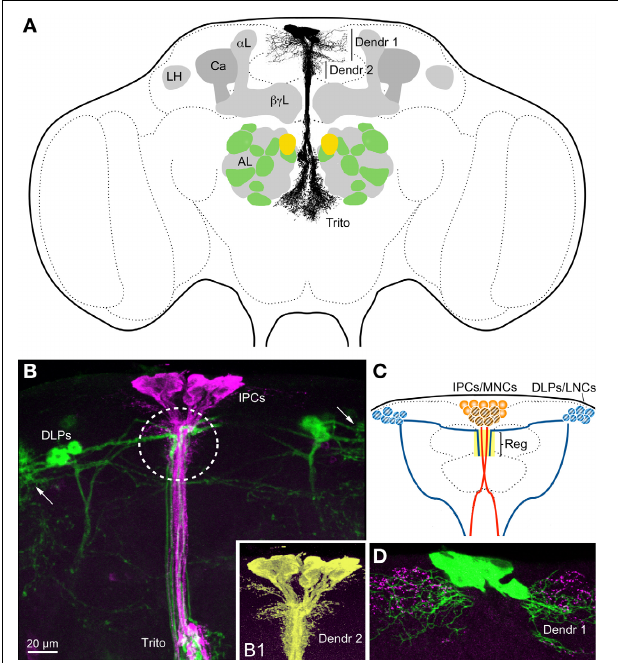
FIGURE 2 | Insulin-producing cells (IPCs) and other neurons in the Drosophila brain. (A) The IPCs are seen with their cell bodies dorsally, two sets of presumed dendrites (Dendr 1 and 2) in the pars intercerebralis and processes branching in the (tritocerebrum Trito). It is not known whether these branches are dendrites or axon terminations, or both. The axons that exit to the corpora cardiaca and aorta are not displayed (they exit above the tritocerebrum, in a direction toward the reader). The antennal lobes (AL) are depicted with the anterior 10 (green and yellow) of the about 14 glomeruli that contain olfactory sensory neurons (OSNs) expressing short neuropeptide F (sNPF). The yellow glomeruli are DM1 that receive OSNs expressing odorant receptor Or42b and sNPF, known to be essential for food search. These sNPF-expressing OSNs also express the insulin receptor (dInR) and the sNPF receptor. DILPs are known to modulate odor sensitivity of these OSNs (Root et al., 2011). The mushroom bodies with calyx (Ca), α -, β - and γ -lobes ( α L, βγ L) and the lateral horn (LH) are also depicted. The mushroom bodies also seem to be targeted by DILPs, at least in larvae (Zhao and Campos, 2012). (B) The IPCs (magenta, anti-DILP2) and corazonin-expressing DLP neurons (GFP, green) converge medially in the pars intercerebralis (encircled) and in the tritocerebrum (Trito). The DLPs are known to regulate IPC activity (Kapan et al., 2012). Arrows indicate the likely dendrites of the DLPs. (B1) Detail of IPCs (enhanced color) visualizing the short dendrites (Dendr 2) that seem to receive inputs from DLPs. (C) Schematic depiction of IPCs, DLPs and their point of convergence in the pars intercerebralis (Reg). The IPCs are located in the MNC cluster and the DLPs among the LNCs. For further details see Figure 3 . (D) The IPCs (green) may receive inputs from serotonin-producing neuron branches (magenta) both at the long dendrites (Dendr 1) and the short (not shown here). Panel (B) is altered from Kapan et al. (2012) and 2D from Luo et al. (2012).